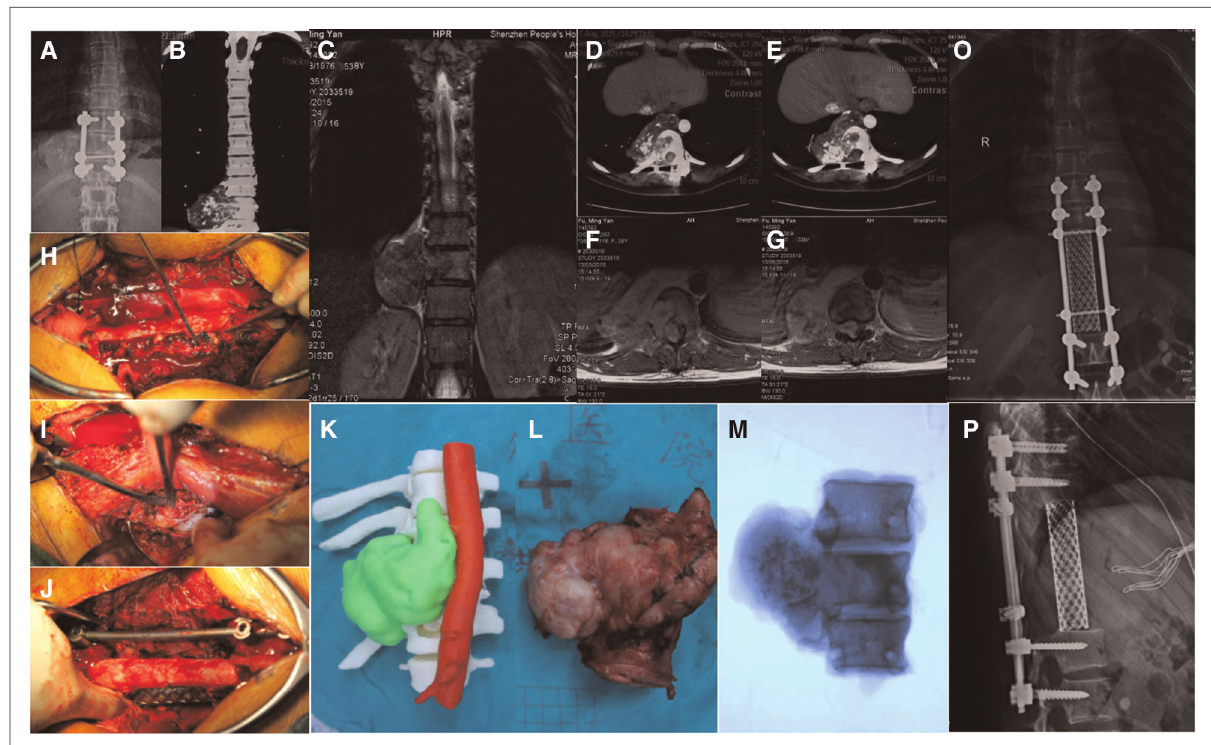
FIGURE 1 Recurrent chondrosarcoma in a 39 years old female (case 2): ( A – G ) the tumor involved T10-T12 with huge paravertebral mass; ( H – J ) En bloc resection of tumor via the combined posterior median and Wiltse approach; ( K ) 3-D printed tumor model; ( L,M ) the overview and radiologic view showed the negative margin of resected tumor. ( O,P ) the reconstruction